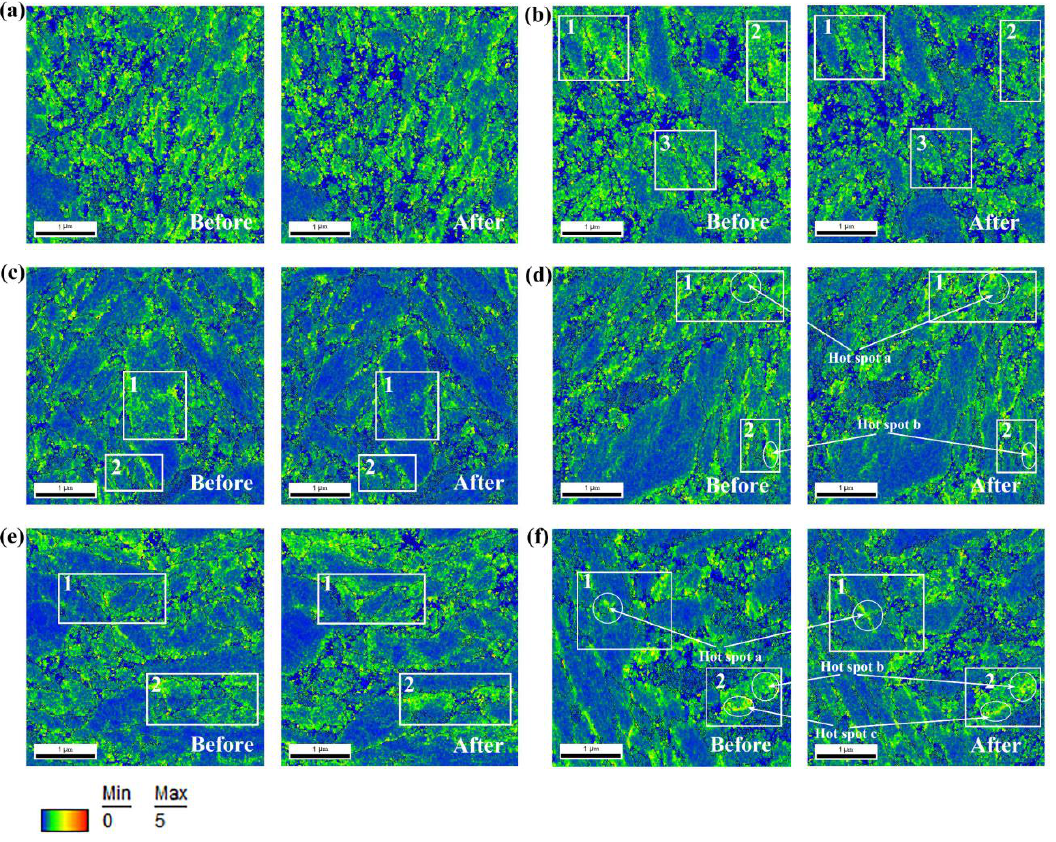
Figure 4. Kernel averaged misorientation (KAM) maps before and after treatment at different magnetic fields. ( a ) 0 T; ( b ) 1.0 T; ( c ) 1.3 T; ( d ) 1.5 T; ( e ) 2.0 T; ( f ) 2.5 T.